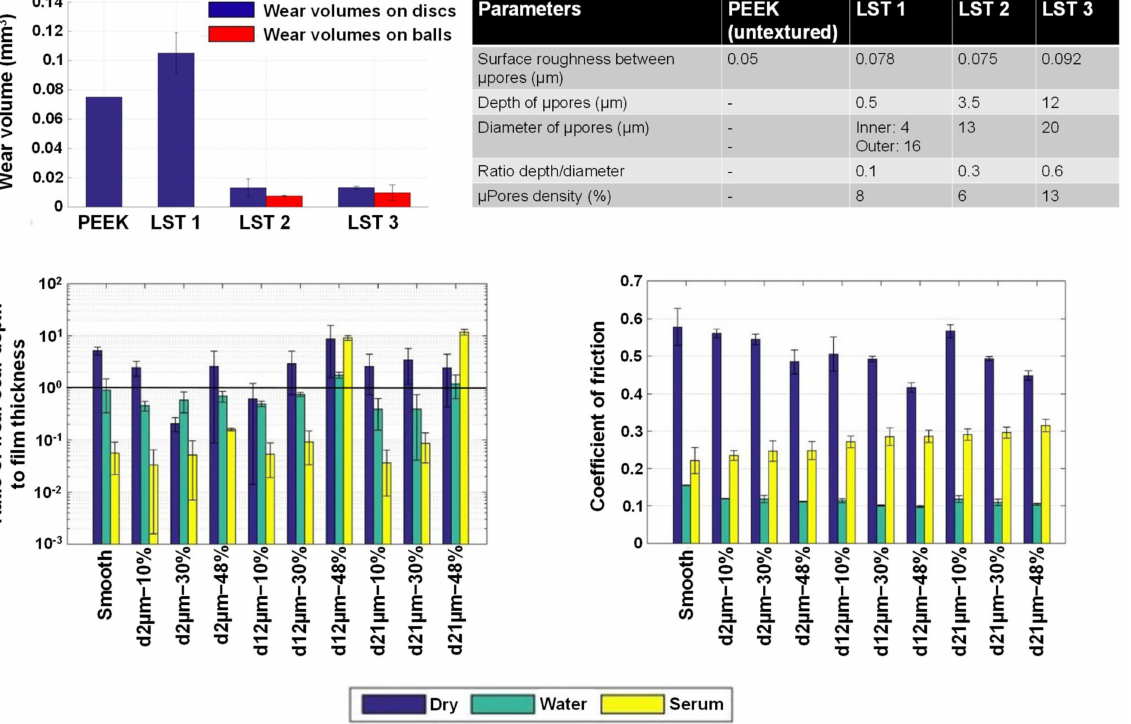
Figure 12. The effect of laser treatment on tribology-resistance. ( a ) Hammouti et al. showed a reduction in wear rate for micropatterned (micropores) PEEK surfaces [211]. ( b ) Dufils et al. demonstrated reduced wear and friction on microstructured PEEK surfaces (micropores coated with DLC film), especially those with shallower micropores and lower area coverage (in water and serum, respectively) in comparison to untreated PEEK [214]. All figures were reprinted with permission from the literature